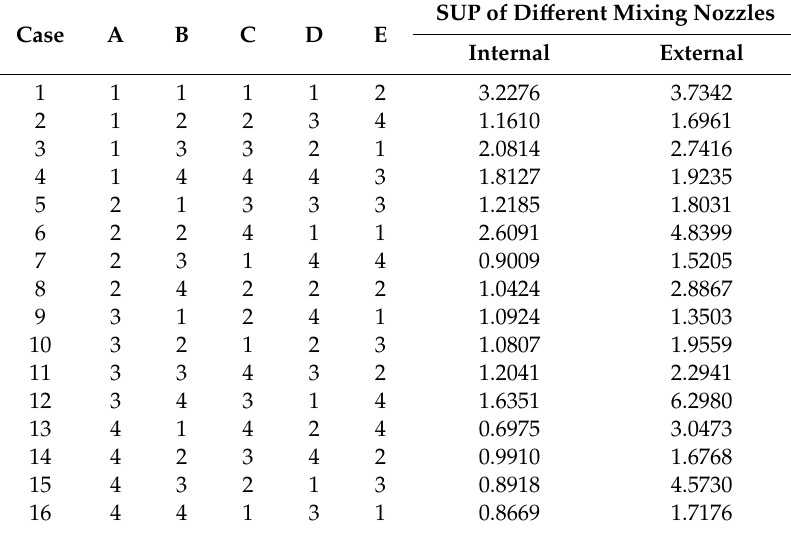
Table 2. Orthogonal table of L 16 4 5 , and the simulation results of two types of mixing nozzles.